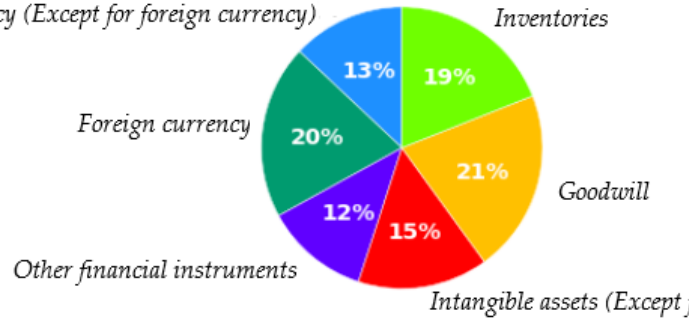
Figure 6. Answers for question of how companies to account for holdings of cryptocurrencies?